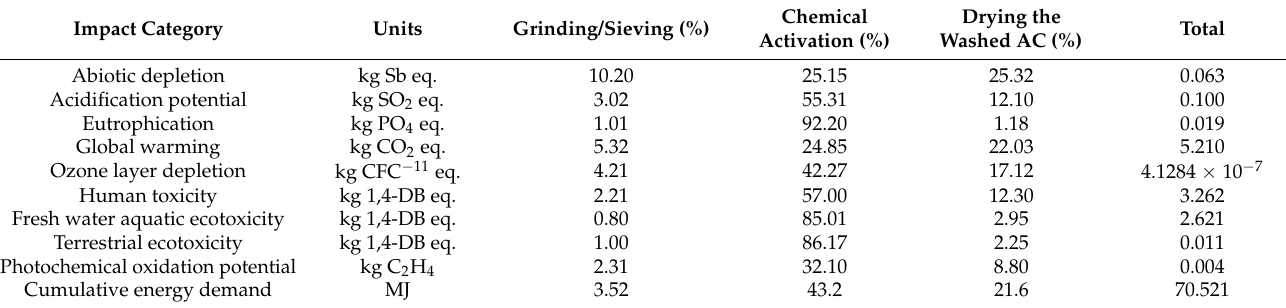
Figure 5. FT-IR analysis of activated carbon prepared from olive trees and Lantana camara . Table 5. Environmental impact of AC production process from olive